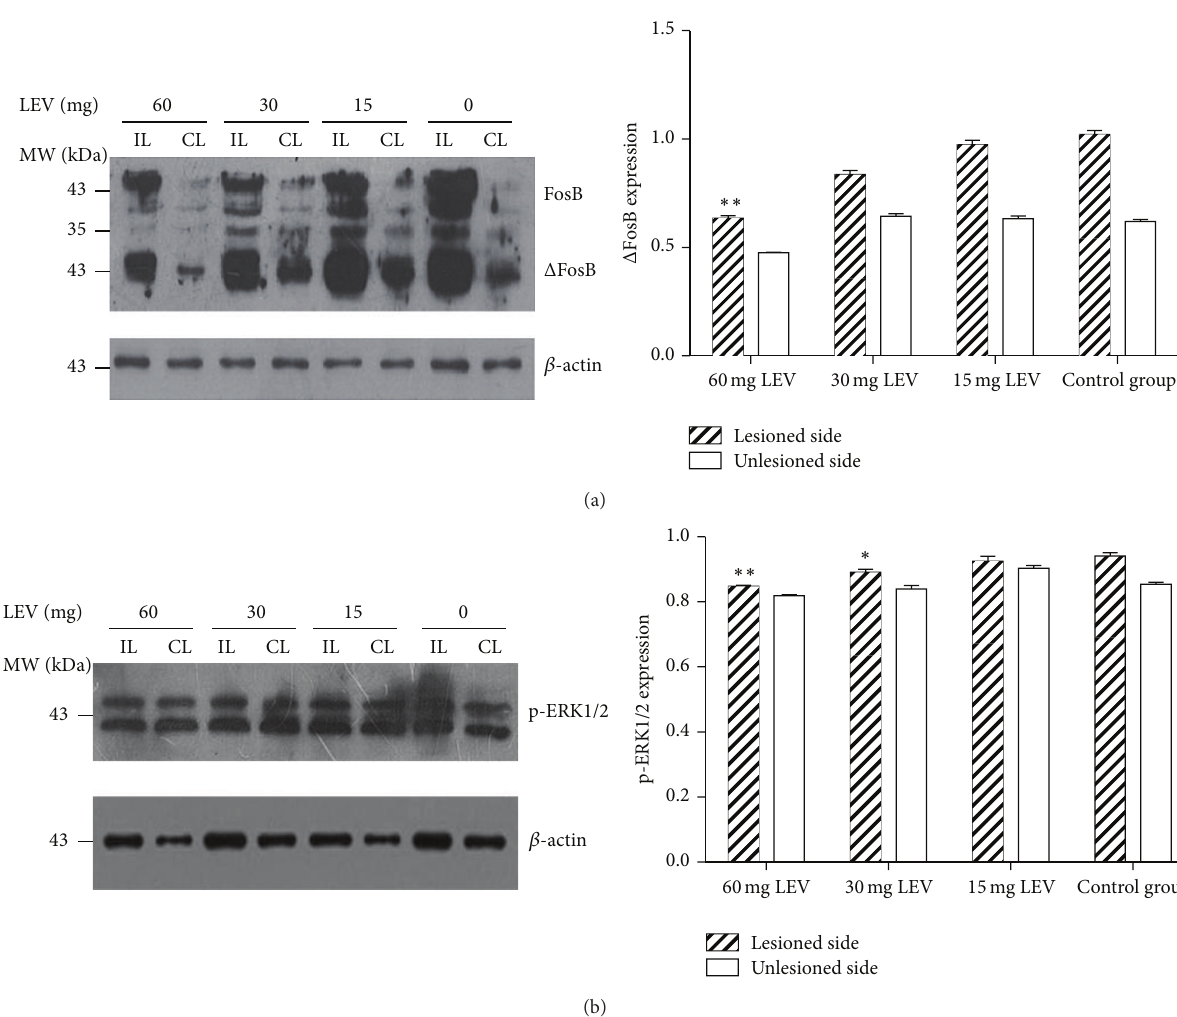
Figure 3: Levetiracetam-induced expression changes of the Δ FosB and phosphorylation of ERK1/2 in the dorsolateral portion of the striatum. Images display immunoblots from striatal tissue (IL: ipsilateral side; CL: contralateral side) from one animal in each levetiracetam treatment group,andimmunoblotscorrespondtoFosB, Δ FosB,and 𝛽 -actinasinternalcontrol.Levetiracetam60mg/kgsignificantlyreducedthestriatal Δ FosB expression (a). # 𝑃 < 0.05 versus same side of control group ( 𝑛 = 6 per group; LEV: levetiracetam). Images display immunoblots from striatal tissue (IL: ipsilateral side; CL: contralateral side) from one animal in each levetiracetam treatment group, and immunoblots correspondtop-ERK1/2and 𝛽 -actinasinternalcontrol.Levetiracetam30and60mg/kgsignificantlyreducedthestriatalp-ERK1/2expression (b). ∗ 𝑃 < 0.05 and ∗∗ 𝑃 < 0.01 versus same side of the control group ( 𝑛 = 6 per group; LEV: